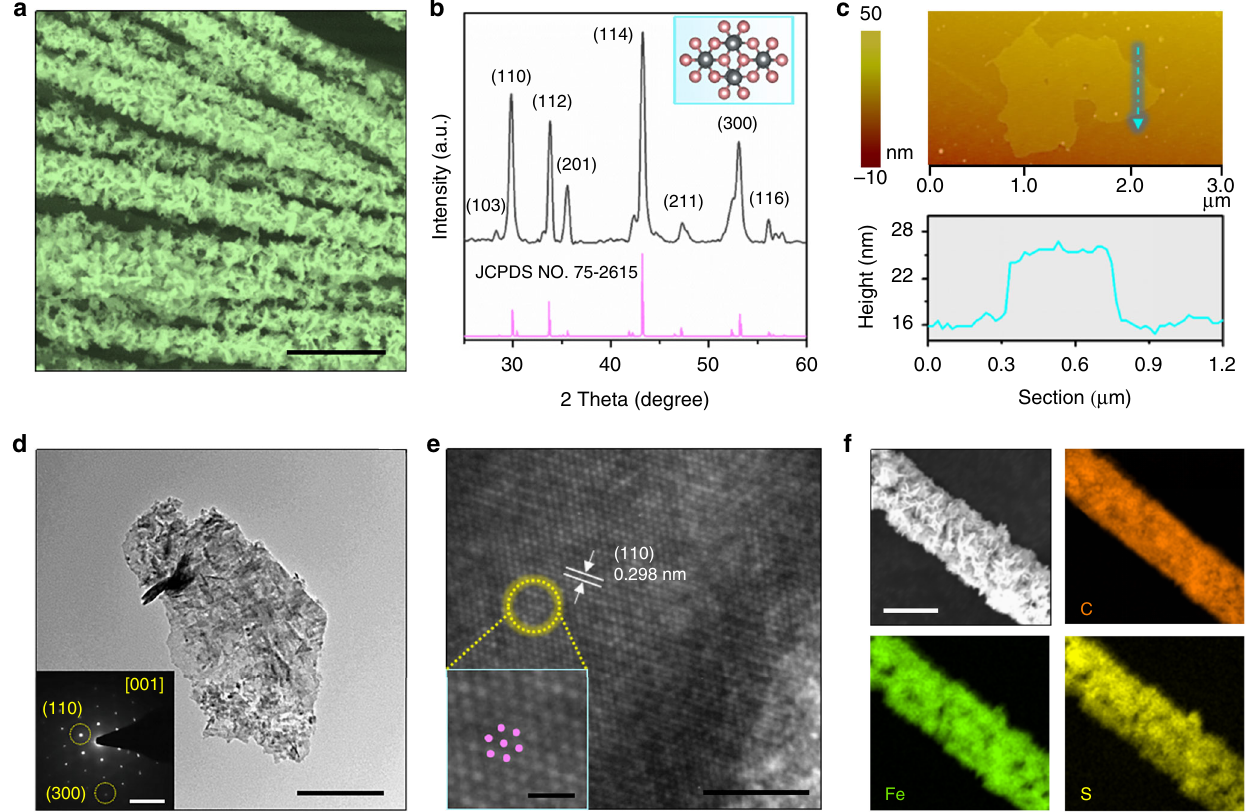
Fig. 1 Characterization of ultrathin troilite FeS nanosheets. a FE-SEM image of FeS nanosheets grown on CFC (scale bar, 50 μ m). b XRD patterns of FeS nanosheets. Inset: atomic structural model. c Top panel: AFM topographical image of a FeS nanosheet. Bottom panel: height pro fi le of a FeS nanosheet is marked by arrow line. d TEM image of a FeS nanosheet (scale bar, 0.4 μ m). Inset: the SAED pattern. e HR-TEM image of a FeS nanosheet (scale bar, 5 nm). Inset: the enlarged image (scale bar, 1 nm). f EDS mapping of FeS nanosheets grown on one carbon fi ber (scale bar, 10 μ